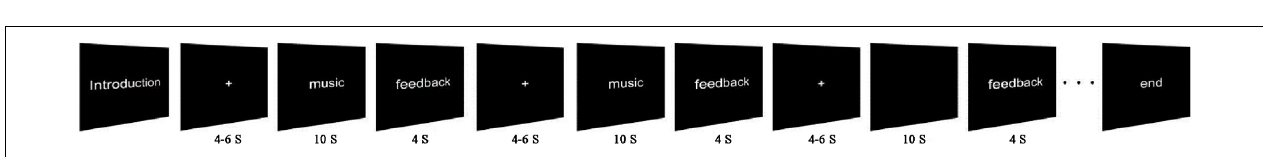
FIGURE 1 | The comparisons of background information between Chinese-trained musicians and Western-trained musicians. (A) Starting age, i.e., the mean age at which participants started to learn how to play the instrument. (B) Weekly training hours, i.e., the mean hours they spend practicing every week reported by the participants. (C) Training years, i.e., the mean total number of years since they started to learn the instrument. (D) Total training hours, which is calculated by weekly training hours × the number of weeks in a year × training years. There was no significant difference between the two types of musicians in these results. (E,F) Musicians have significant differences in familiarity with Chinese and Western music styles. Specifically, compared with Western-trained musicians, Chinese-trained musicians are more familiar with Chinese music style. In addition, compared with Chinese-trained musicians, Western-trained musicians are more familiar with Western music style.